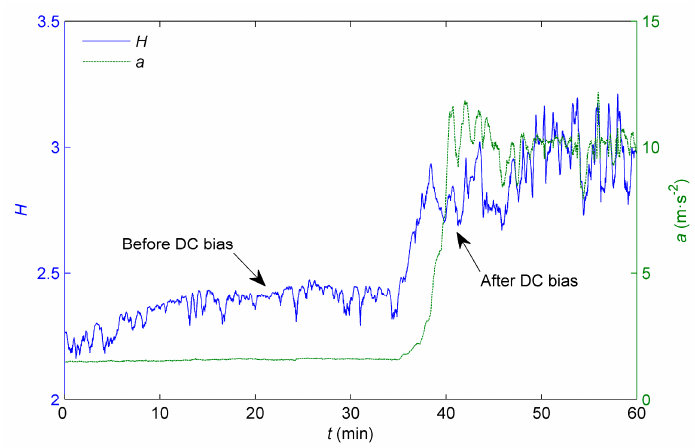
Figure 6. Feature H variation process with time.